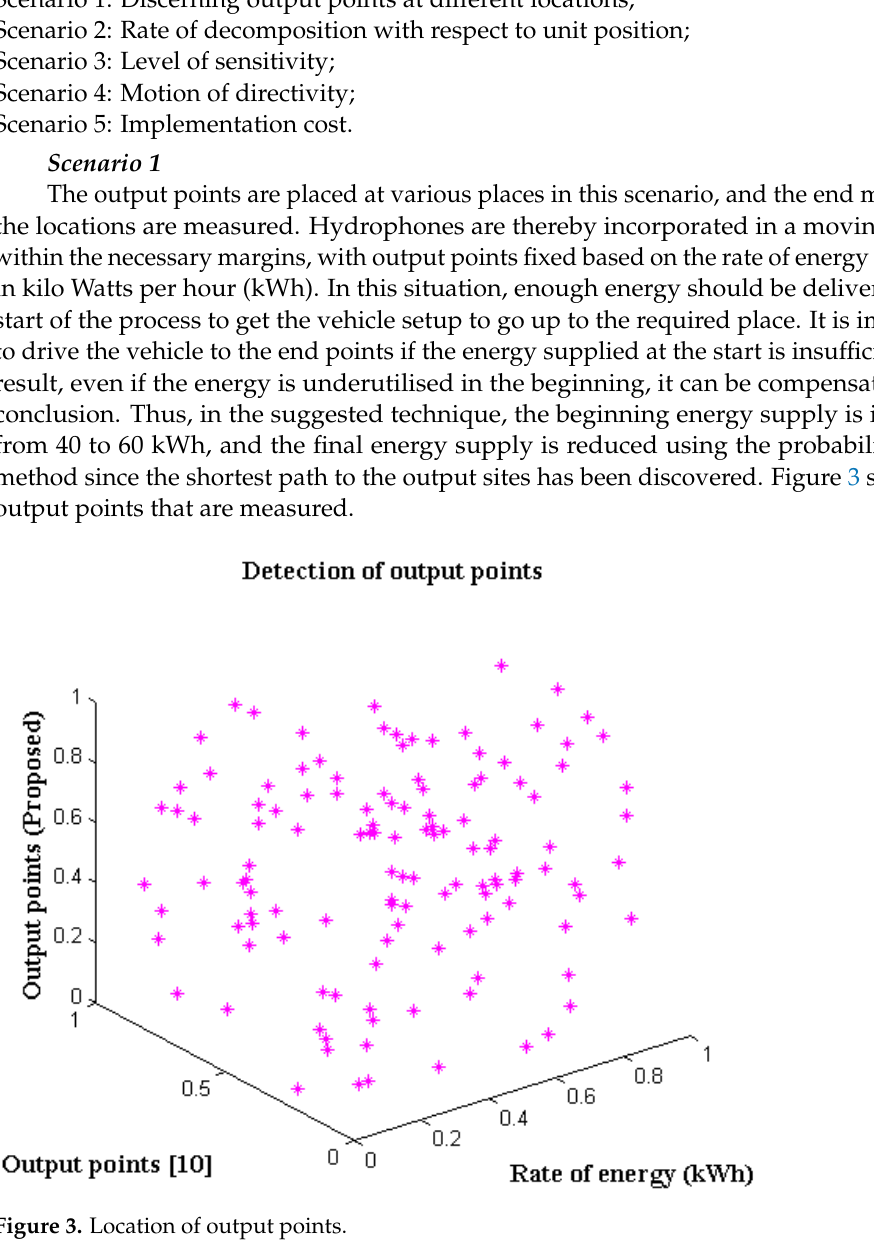
Figure 3. Location of output points.